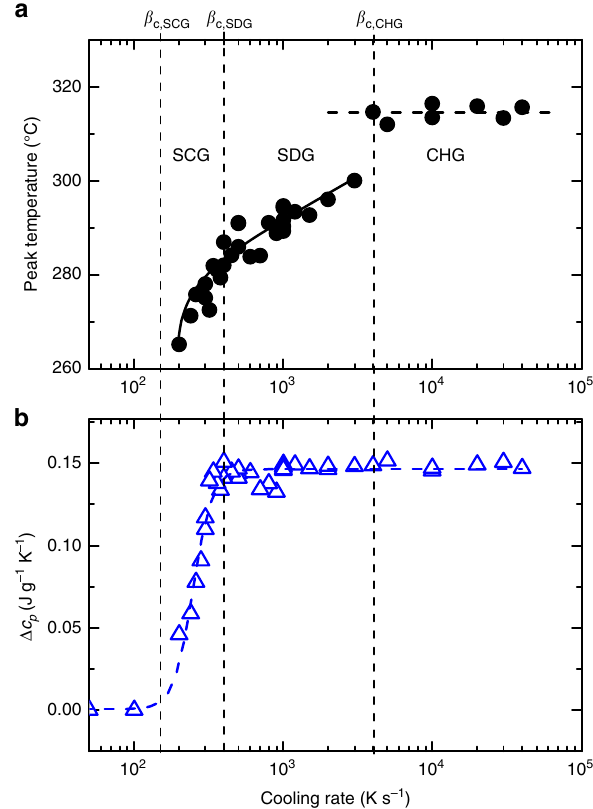
Fig. 2 Cooling rate dependence of the crystallization peak and glass transition. Data derived from the heating curves measured at 1000 K s − 1 vs. cooling rate at which the glass was formed (see Fig. 1b). a Peak temperature of crystallization event. b Intensity of the glass transition, Δ c p . The solid curve in a results from a fi t using Eq. (1); the dashed curves in a and b are guides for the